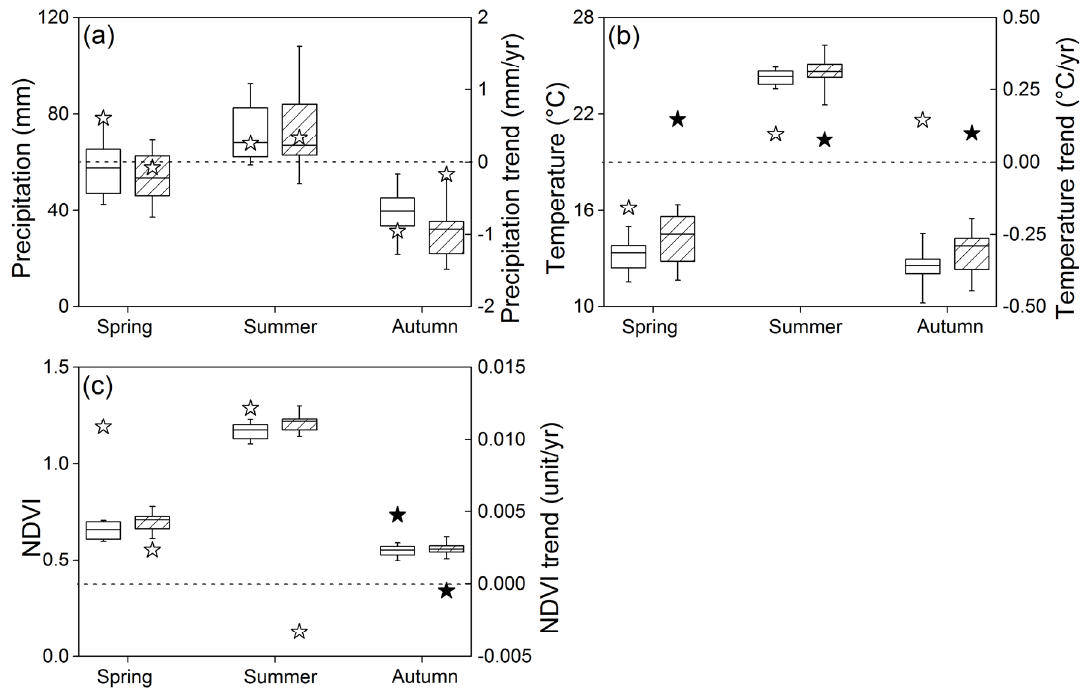
Figure 6. Inter-annual variations and trends for the seasonal ( a ) precipitation, ( b ) temperature, and ( c ) NDVI in 1982–1991 and 1992–2011 in Central Asia. The boxes represent the values for the second and third quartiles, the horizontal line gives the median, and the whiskers show the lowest/highest values. The hollow stars indicate the temporal trends in precipitation, temperature, and NDVI for the different seasons, while the solid stars show the significant trends ( p -value <